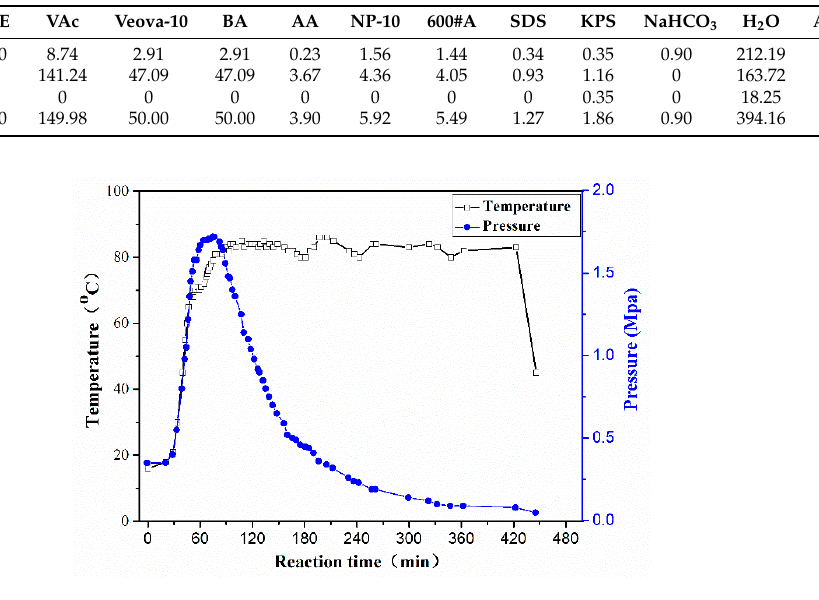
Figure 1. Change curve of pressure and temperature of polymerization ( P1 ).